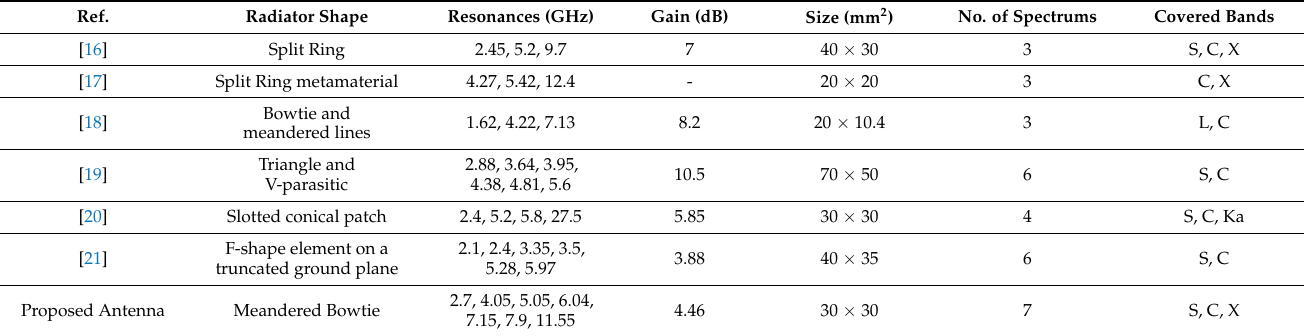
Table 6. Comparison of this work with other multiband